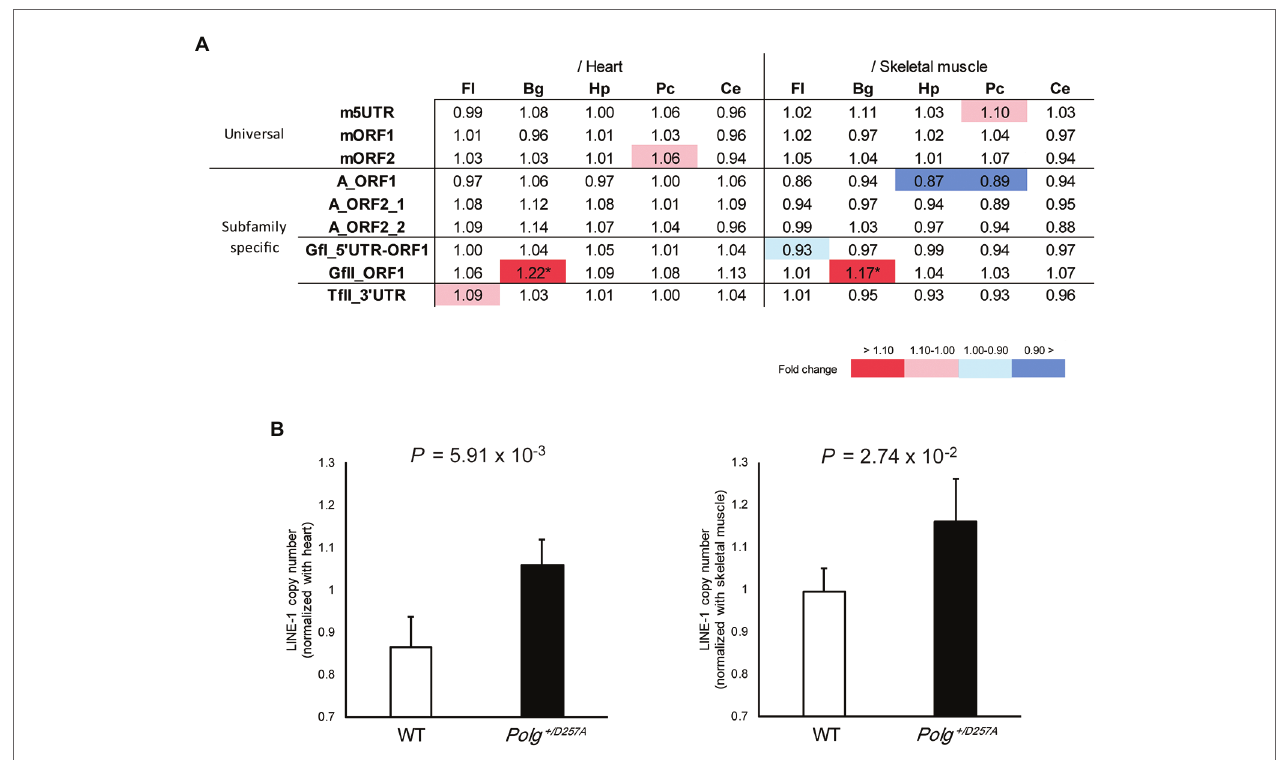
FIGURE 2 | LINE-1 copy number detected in 84-week-old Polg +/D257A mouse brain. (A) Changes in LINE-1 content in Polg +/D257A mice ( n = 4) and wild-type mice ( n = 4). The fold change relative to wild-type mice is shown in each reference tissue. Color indicates the extent of fold change with a nominal significant difference (Welch’s t -test, p < 0.05). * Indicates a robust change defined as significant in both references (Welch’s t -test, p < 0.05 in both tissues). Fl, frontal lobe; Hp, hippocampus; Pc, posterior cortex; Bg, basal ganglia; Ce, cerebellum. (B) LINE-1 copy number in the basal ganglia measured using the primer pair GfII_ORF1. The copy number in the brain was normalized to the number in the heart (left panel) or skeletal muscle (right panel). Data are represented as the mean ± standard deviation. WT, wild-type mice. All the comparisons were listed in Supplementary Figure S3